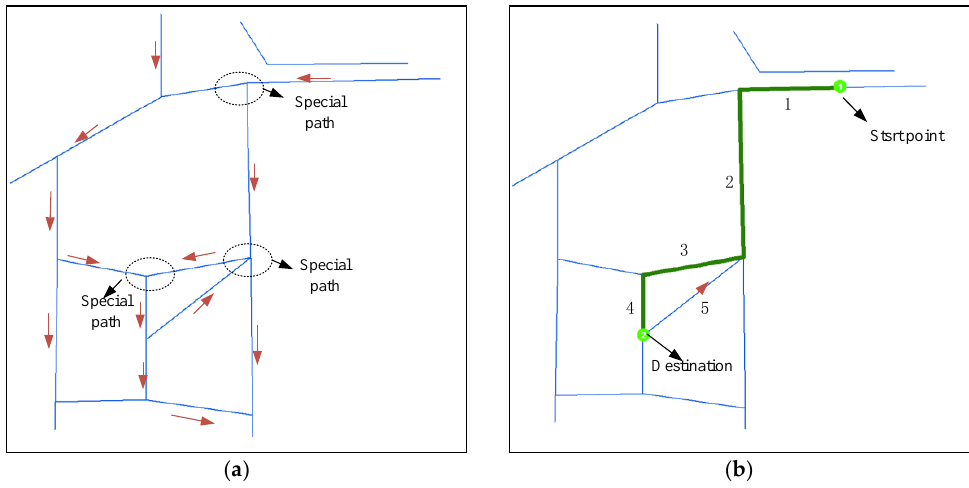
Figure 11. Simulation for global planning. ( a ) Map-building; ( b ) global path planning.